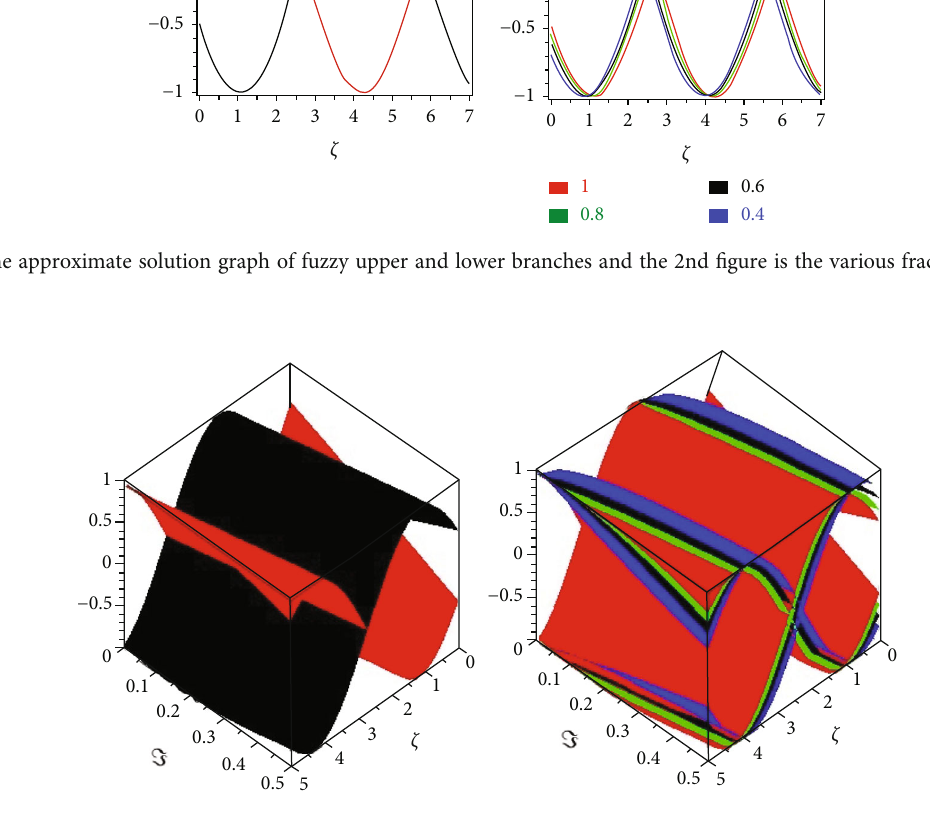
Figure 3: The fi rst graph shows the approximate solution of fuzzy upper and lower portions, and the second fi gure is the various fractional order of ℘